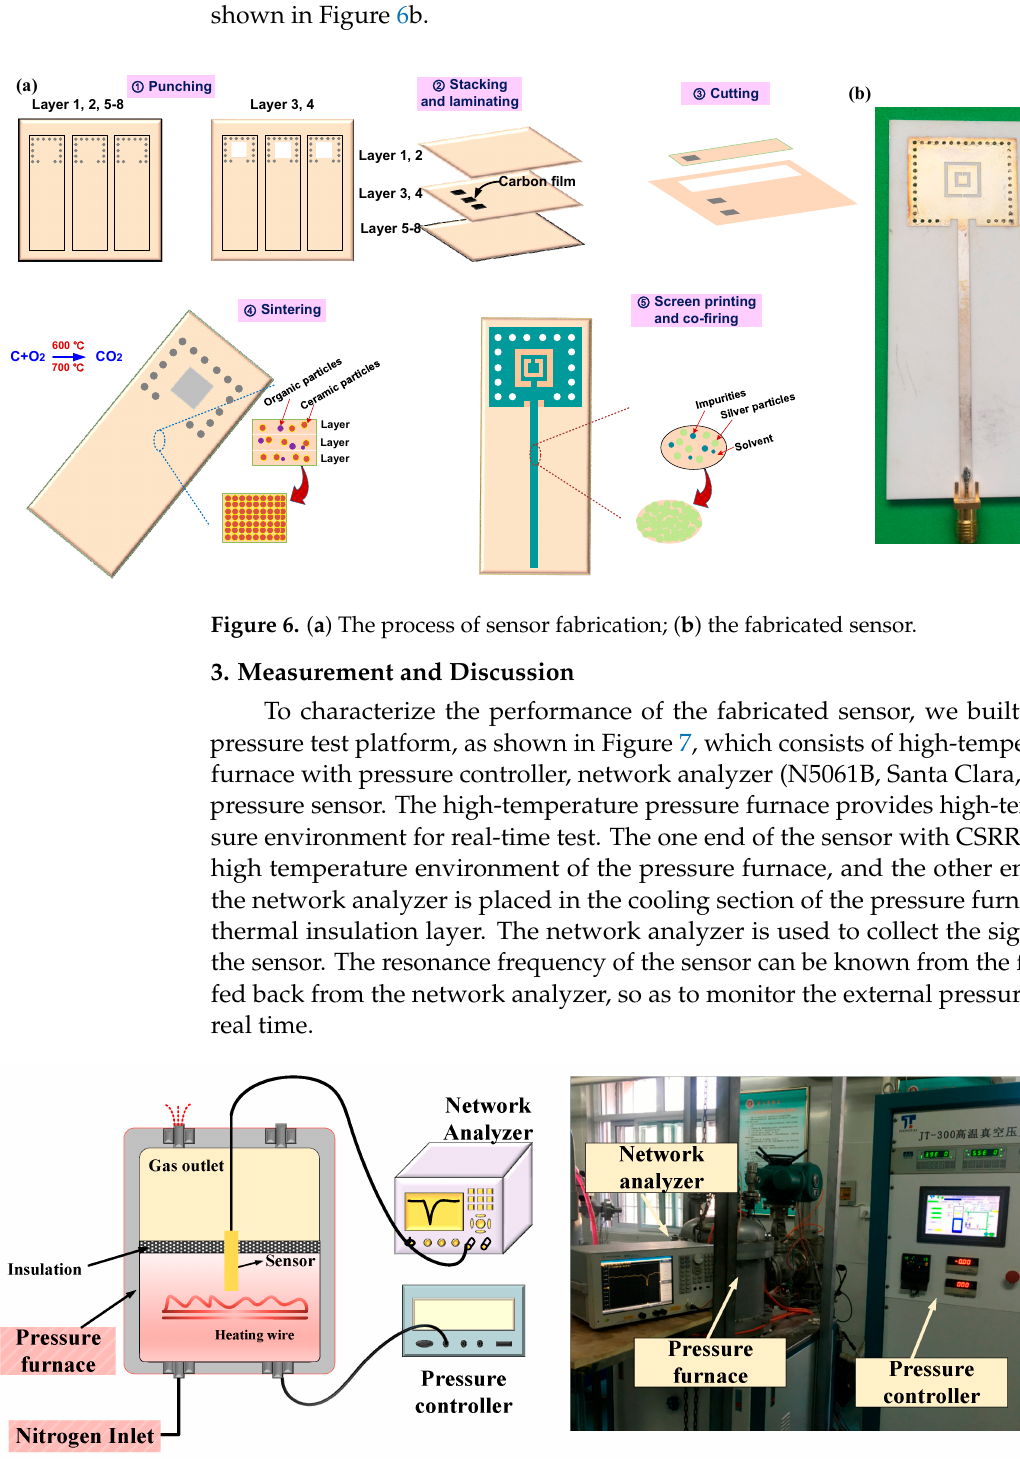
Figure 7. High-temperature pressure measurement platform.